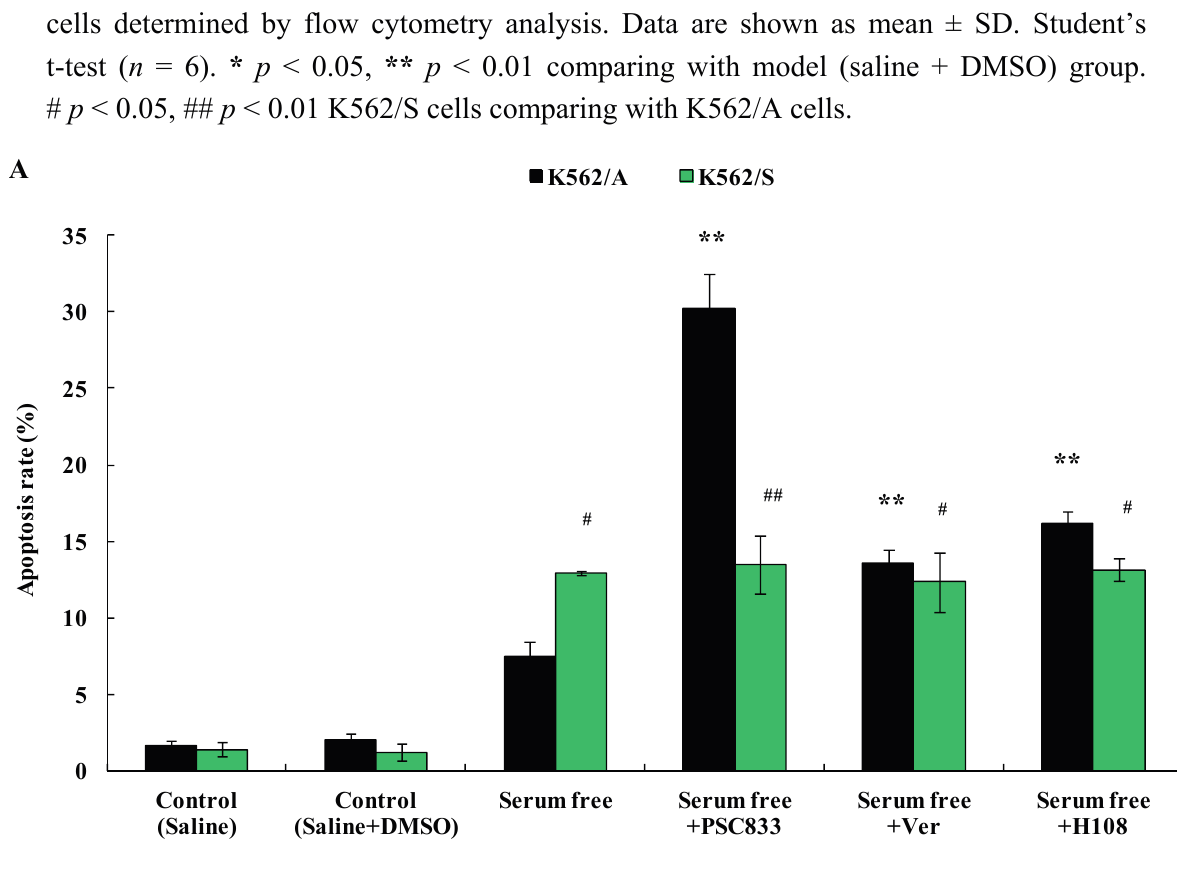
Figure 3. Apoptosis of K562/A and K562/S induced via serum deprivation and effects of P-gp inhibitors. Both cell lines were incubated with serum free culture medium, or in combination with PSC833 (0.1 µM), Ver (5 µM), H108 (5 µM), respectively for 48